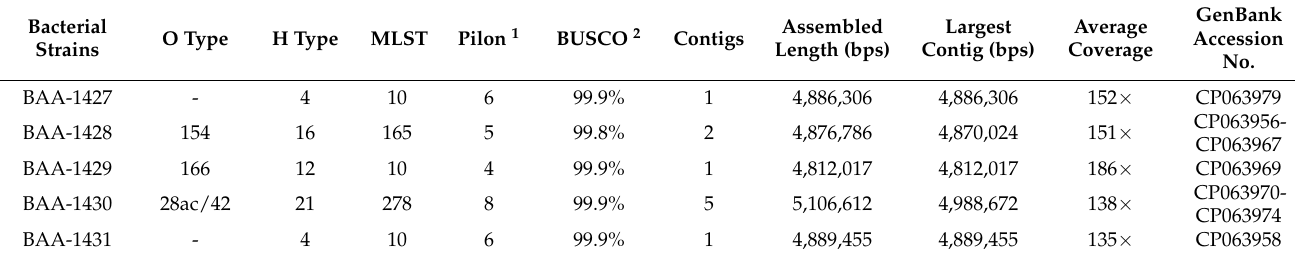
1 Indicates the number of rounds of error correction each assembly underwent during Pilon processing. 2 Indicates the predicted com- pleteness of each assembly generated by BUSCO (Benchmarking Universal Single-Copy Orthologs) after comparison to the lineage